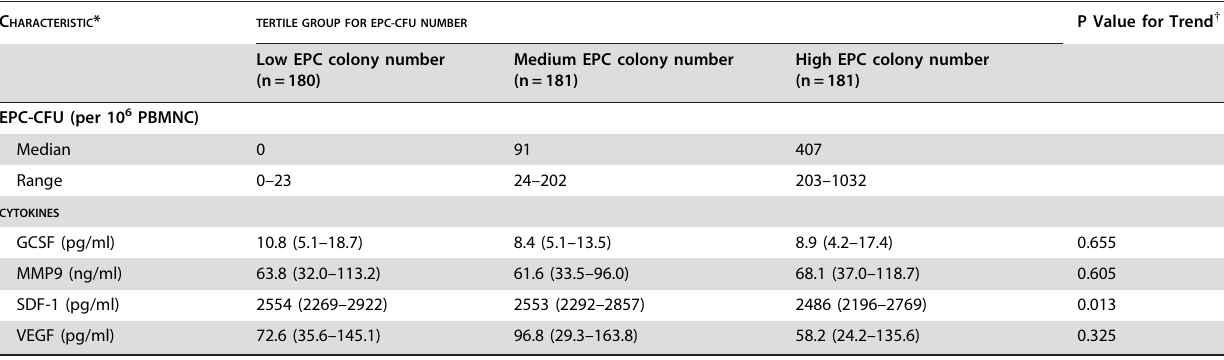
Table 4. Association of cytokines with EPC colonY number (n= 542) .. ... .... ... ... .... ... ... .... ... ... .... ... ... .... ... ... .... ... ... .... ... ... .... ... ... .... ... ... .... ... ... .... ... ... .... ... ... .... ... ... .... ... ... . C HARACTERISTIC *